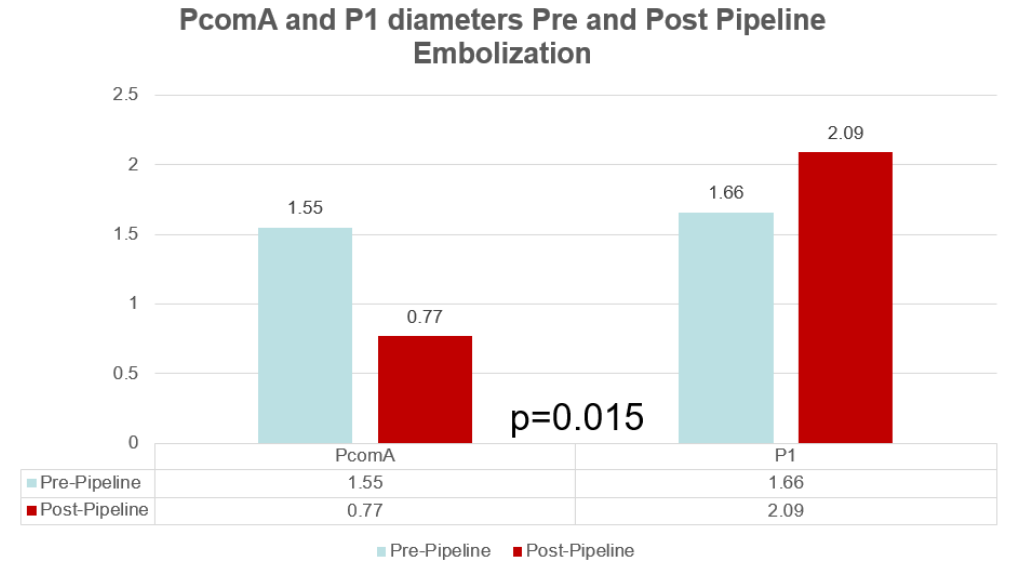
Figure 2. PcomA and P1 diameters pre and post pipeline embolization.